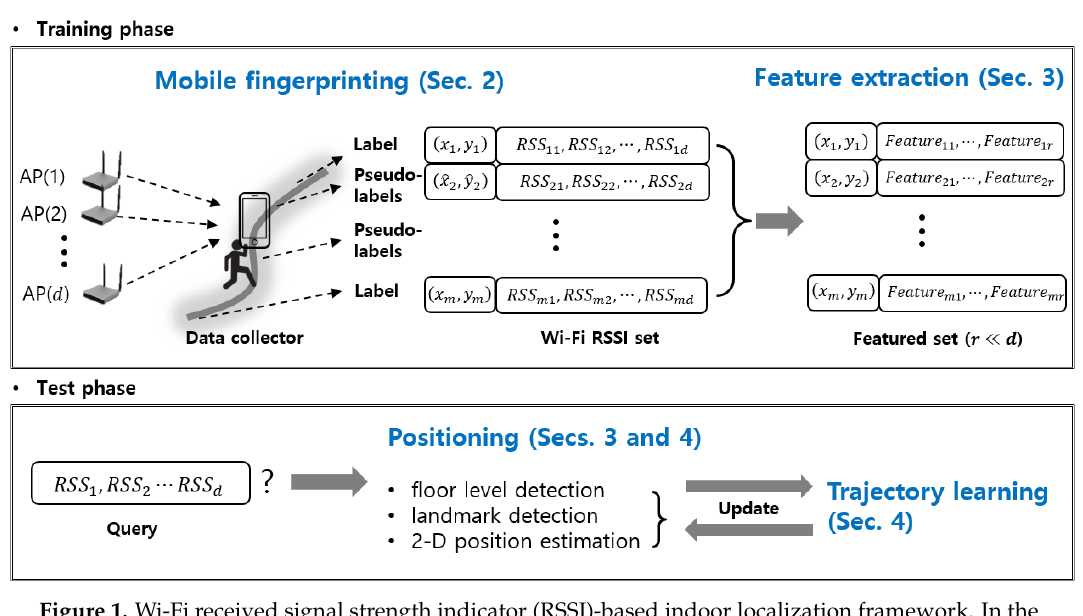
Figure 1. Wi-Fi received signal strength indicator (RSSI)-based indoor localization framework. In the training phase, the mobile fingerprinting for data collection and the feature extraction are conducted. The feature extraction models are applied to the floor level and landmark detections in the test phase. Also, the trajectory learning is proposed for improving position estimation accuracy. The positioning composes the 2D position estimation, floor classification, and landmark detections by using the same RSSI